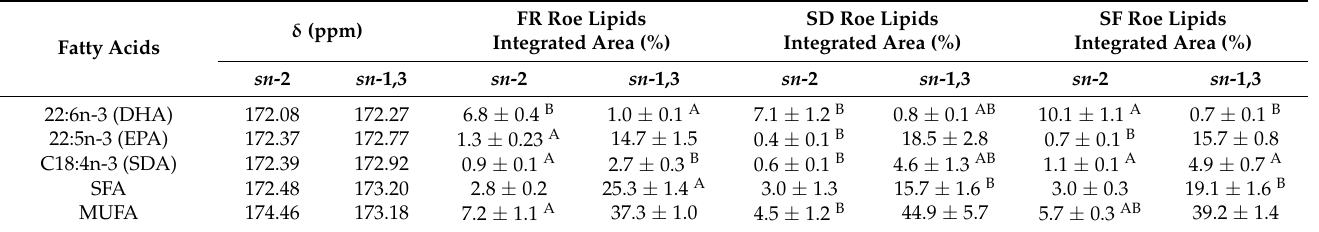
Table 1. 13 C NMR carbonyl region fatty acid sn -2 and sn -1,3 positional distribution in lipid extracted from fresh (FR), salted (SD), and fermented (SF) salmon roe and their